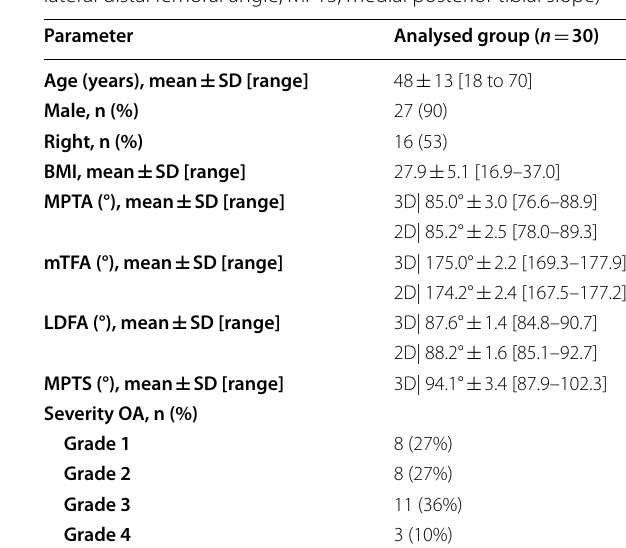
Fig. 5 Postoperative 3D accuracy analysis by matching the pre-and postoperative proximal tibia plateaus